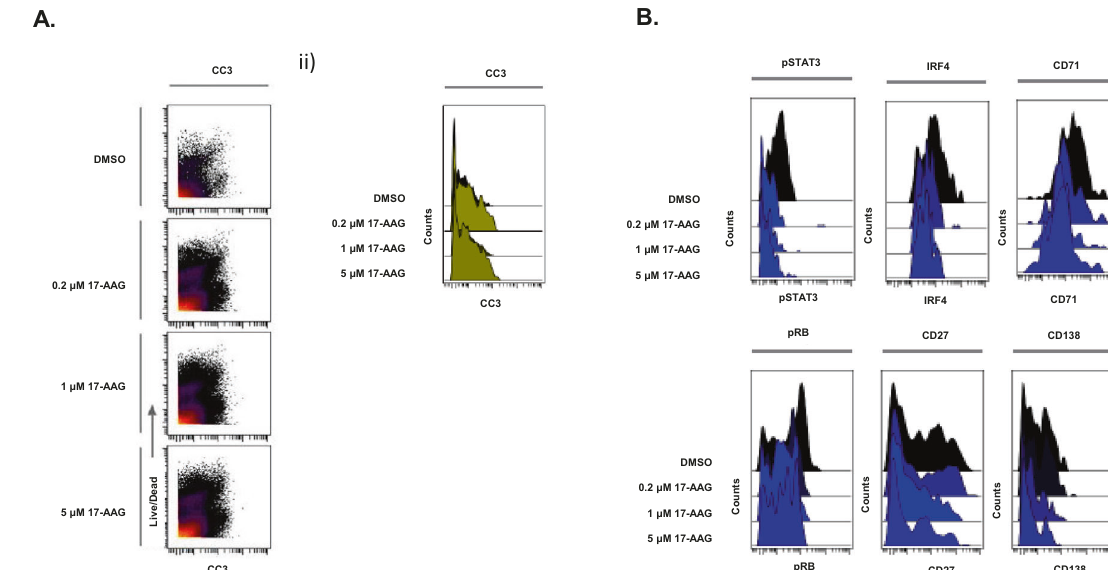
Fig. 4 Representative fi gures showing CyTOF analysis results in patient primary multiple myeloma cells. CyTOF analysis was performed on Live cells ( n = 6). A 17-AAG induces elevated cleaved caspase 3 levels. Samples were treated with 17-AAG (2, 5, and 10 μ M) or DMSO and Gated on LIVE cells. (i) The FlowSOM meta-cluster results were condensed into cc3 positive and negative cell subsets based on cc3 expression UMAPs and plotted over CLF dose. (ii) cc3 induction is also shown in the violin plots. B Downregulation of genes associated with myeloma cell survival. Representative violin plots of CyTOF analysis in patient primary myeloma cells showing expression of myeloma markers following 17-AAG treatment, including IRF4, pSTAT3, IZKF3, CD138, CD71, pRB, and CD27.